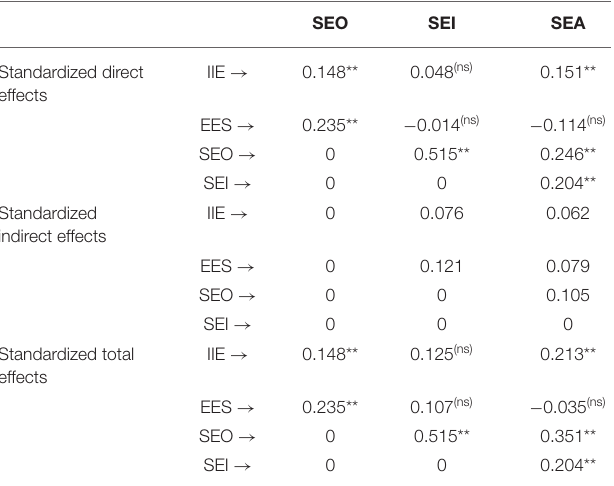
TABLE 13 | Direct effect, indirect effect, and the total effect of each variable. SEO SEI